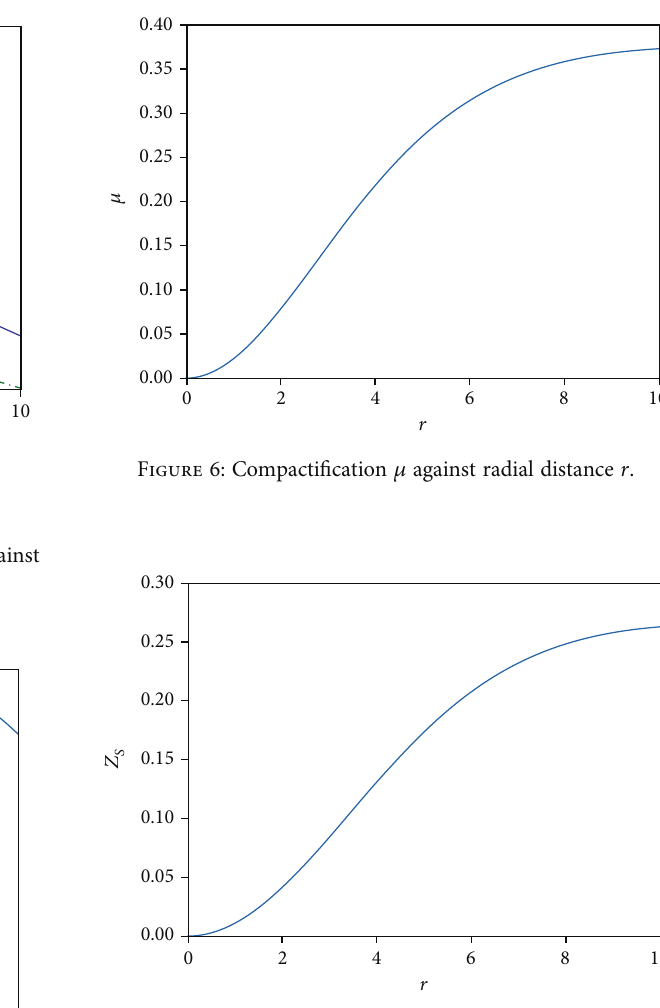
Figure 7: Surface redshift against radial distance r .